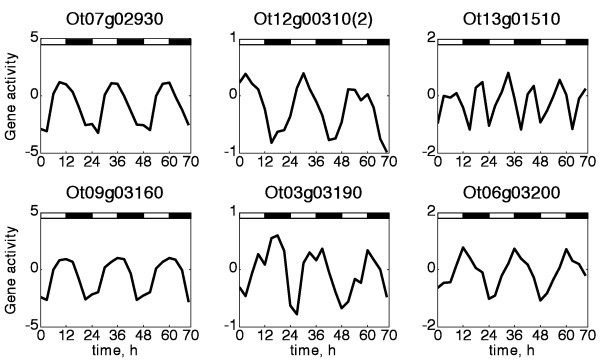
Diurnal mRNA expression profiles for selected genes. From left to right, upper row: ADP-glucose pyrophosphorylase, (Ot07g02930), isoamylase ISA3 (Ot12g0310), GWD (SEX1) (Ot13g01510). Lower row: maltose transporter MEX1 (Ot03g03160), β-amylase (Ot03g03190), GBSSI (Ot06g03200). The remaining profiles are presented in Additional file 1, Figure S6.